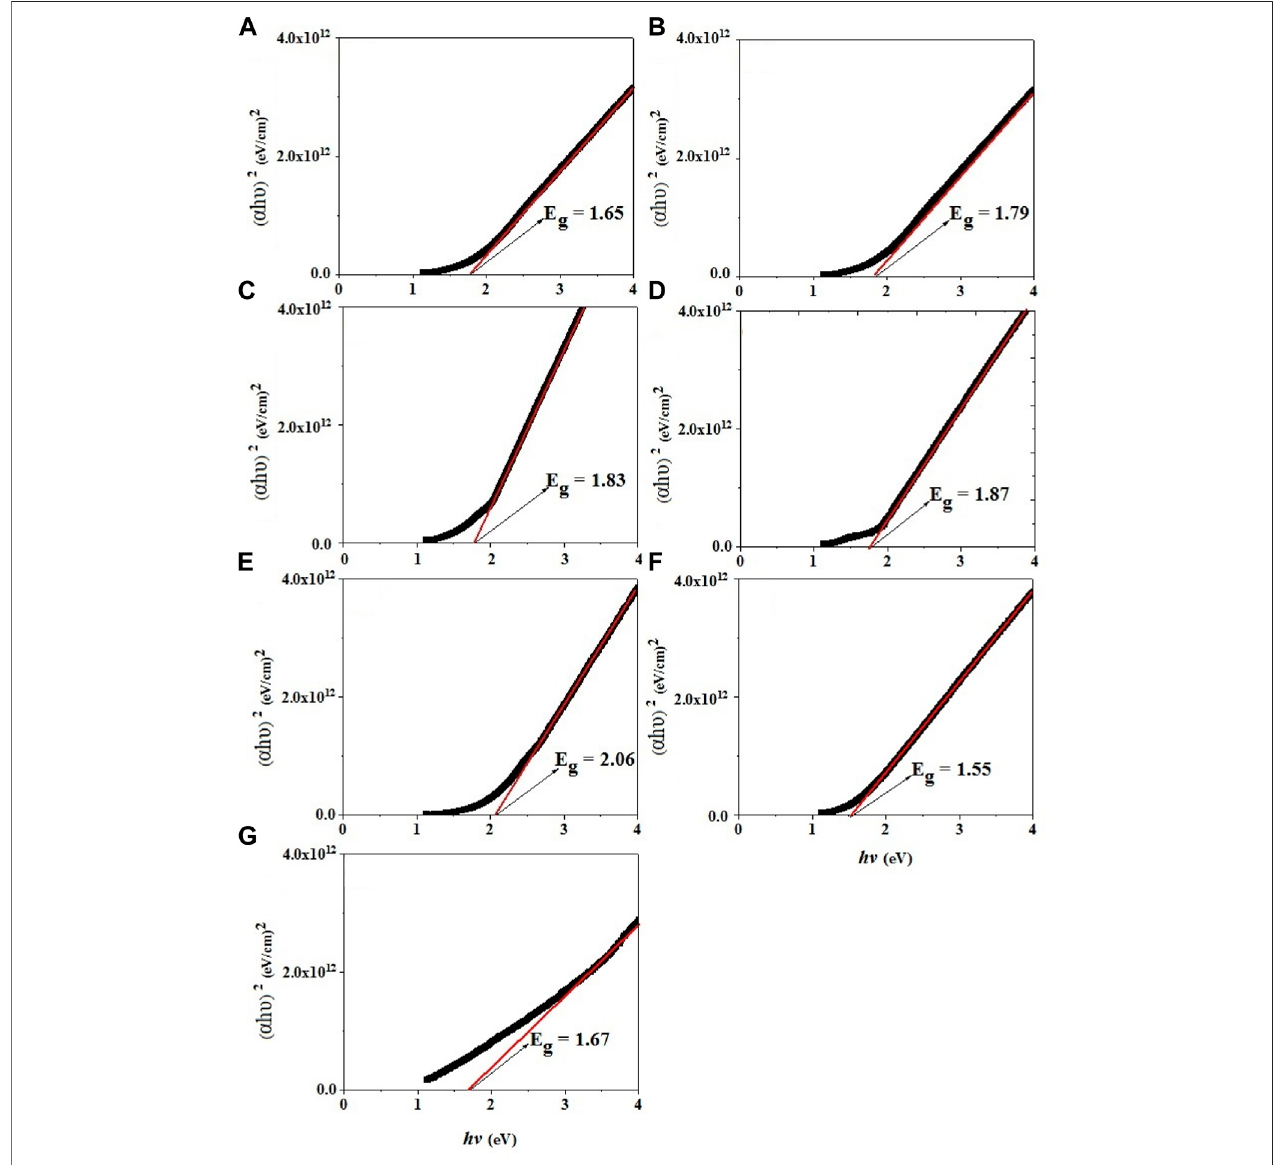
FIGURE 9 | Extrapolation of the linear part of diagram of ( α h ʋ ) 2 versus (h ʋ ) for Mg 0.30- x Cd x Cu 0.2 Zn 0.5 Fe 2 O 4 ferrites (A) x (cid:1) 0.00, (B) x (cid:1) 0.05, (C) x (cid:1) 0.10, (D) x (cid:1) 0.15, (E) x (cid:1) 0.20, (F) x (cid:1) 0.25, (G) x (cid:1) 0.30.